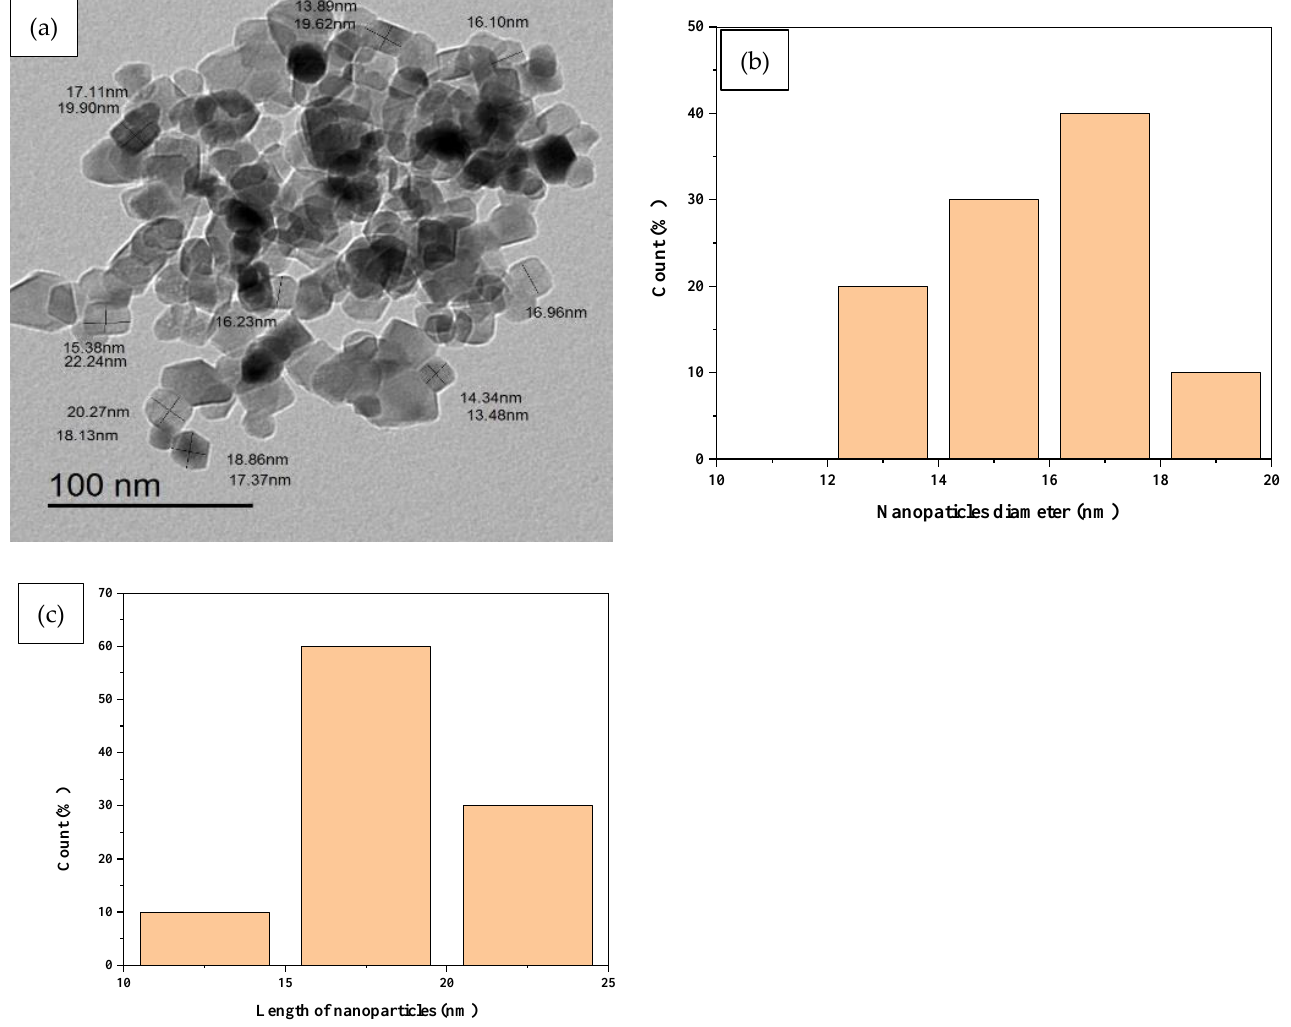
Figure 8. ( a ) TEM image of TiO 2 NPs ( b ) the corresponding histograms of diameter TiO 2 NPs ( c ) the corresponding histograms of length distribution of TiO 2 NPs.